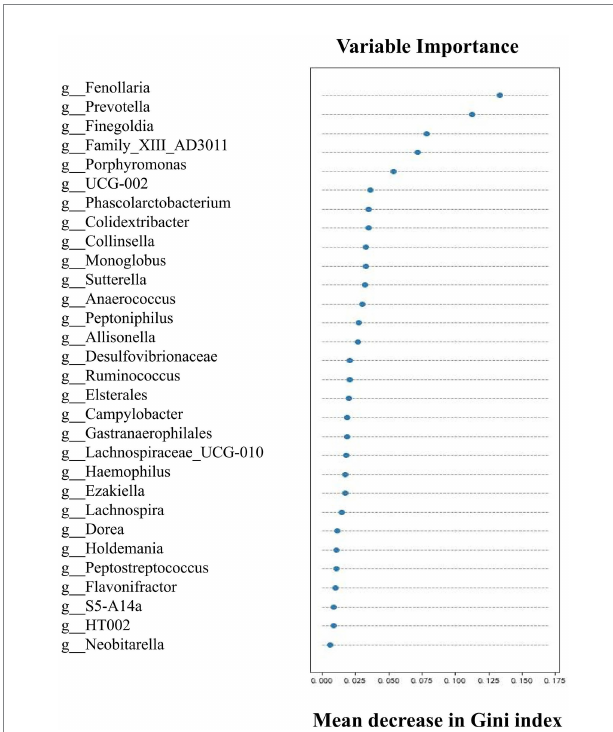
FIGURE 3 Top 30 genera with great importance in distinguishing patients with AAD from healthy controls by random forest modeling. The 30 most important predictors of AAD vs. healthy were ranked by the Gini index determined from the random forest algorithm trained to distinguish the two cohorts. The taxa are ranked from top to bottom by decreasing Gini index. Since Gini index scores quantify the strength of each respective predictor, the best predictors of AAD are at the top of the